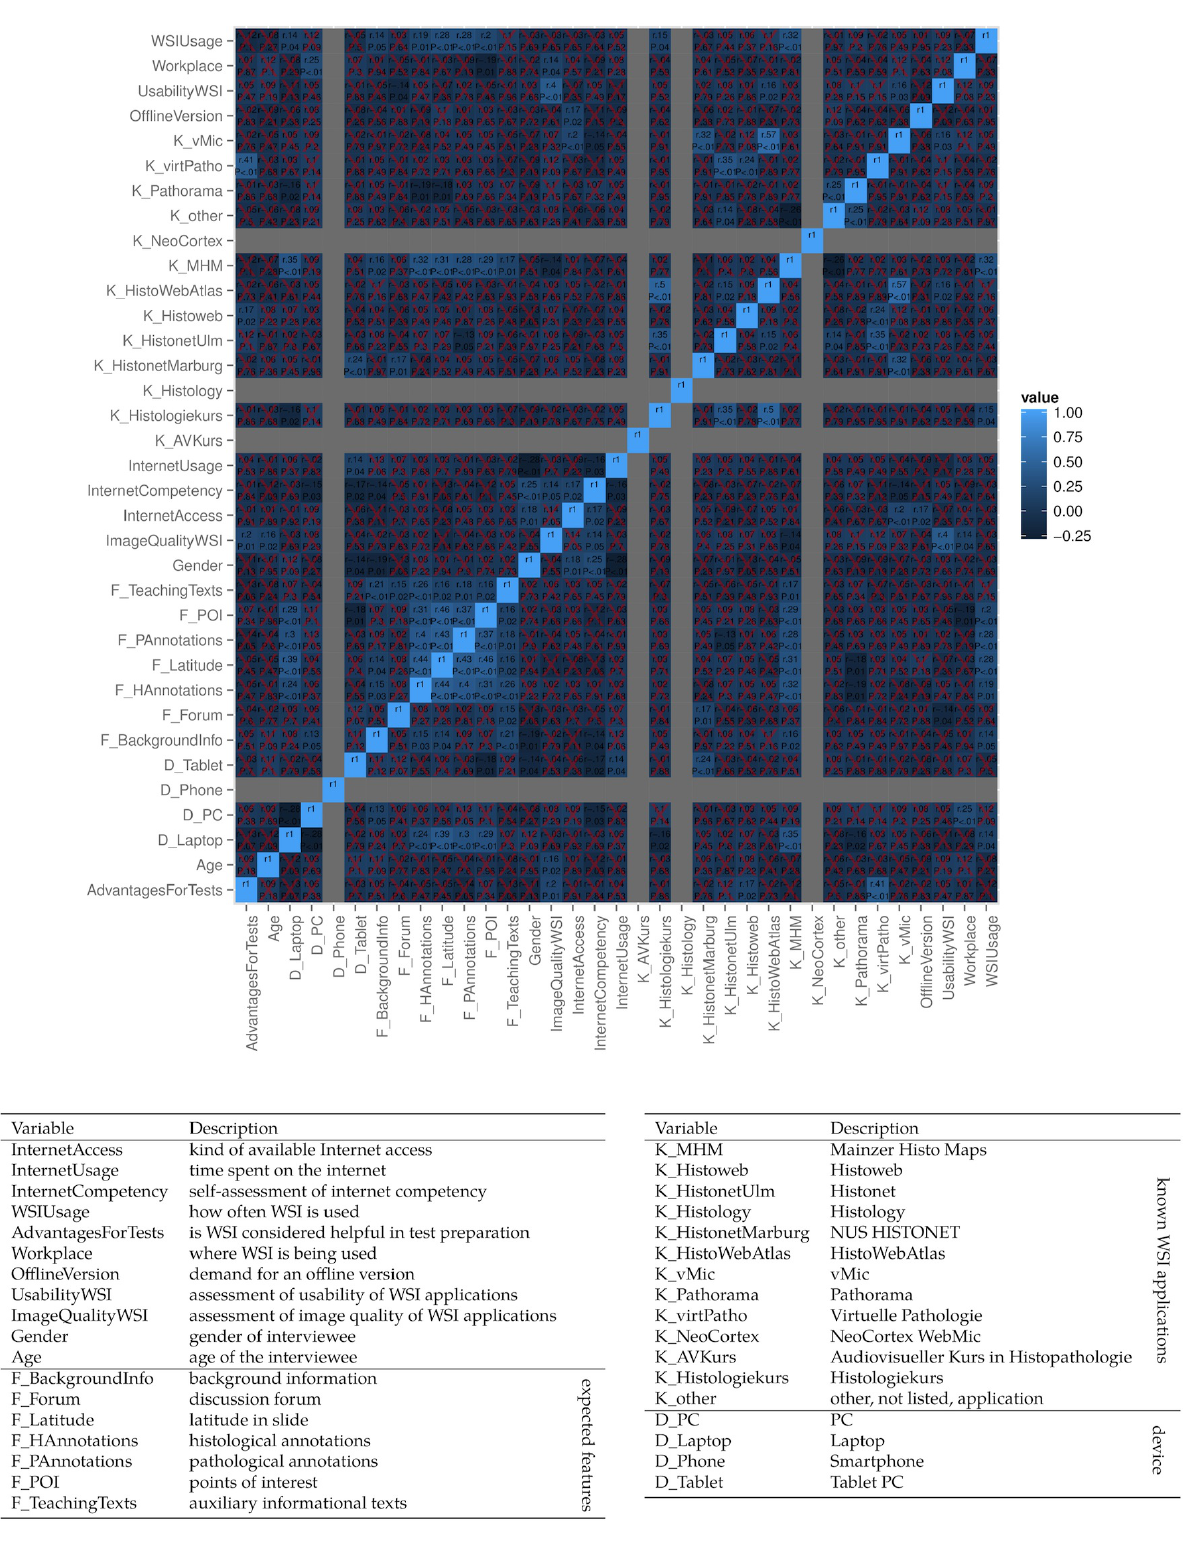
Figure 4. Spearman rank correlation coefficient heat map of the questionnaire items. Each rectangle contains the correlation coefficient in the upper half and the corresponding P value in the lower half, if applicable. A red cross marks individual P values where P <.05. The color of each rectangle indicates the value of the correlation coefficient. The legend below the heat map provides a concise description for each